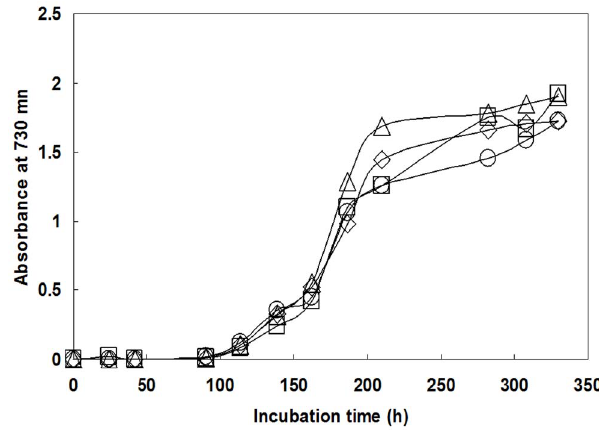
Figure 2. Photomixotrophic growth of WT ( n ), M1 ( % ), M2 ( # ), and M12 ( e ) strains of Synechocystis sp. PCC6803. Cells were grown in a BG-11 medium containing 5 mM glucose and the number of cells were counted in the exponential phase. The same amount of the cells were inoculated in the new media. Each culture was inoculated with an equal number of exponential-phase cells, and growth of the cultures was monitored by measuring absorbance at 730 nm at various time